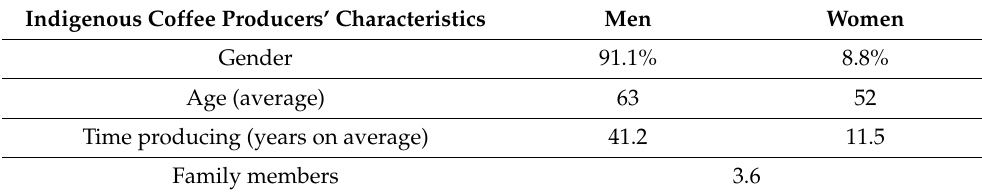
Table 3. Characteristics of indigenous coffee producers from El Pajarito, Llano Coyul, Ocotal, Guadalupe, and Buenavista in Santiago Lachiguiri and San Juan Guichicovi in Oaxaca,